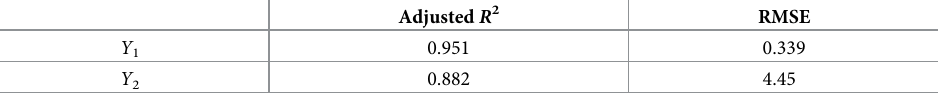
Table 10. Adjusted R 2 and RMSE values for Model W-Accelerated. Y 1 and Y 2 are Δ E and Δ Gloss 60 ,